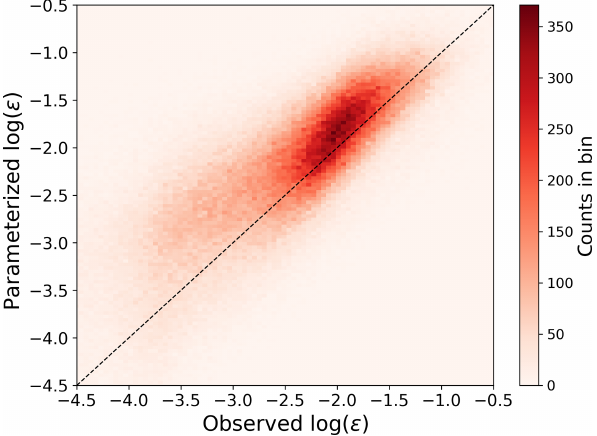
Figure 3. Scatter plot showing the comparison between observed and MYNN-parameterized (cid:15) from the 184 sonic anemometers at